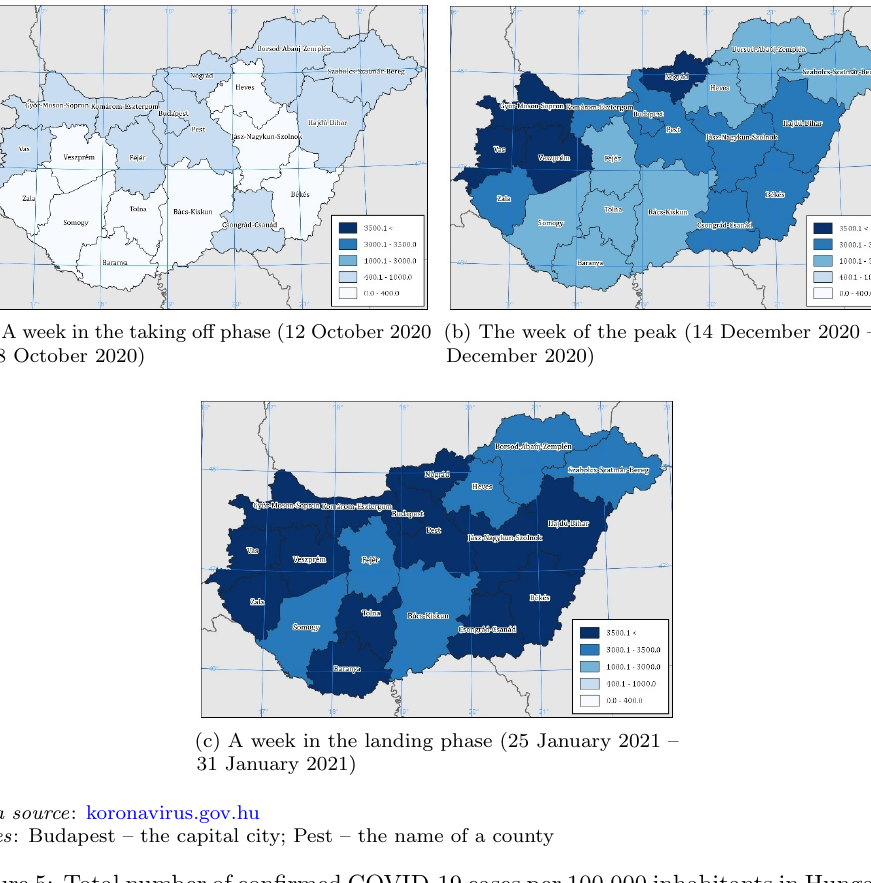
Figure 5: Total number of confirmed COVID-19 cases per 100,000 inhabitants in Hungarian counties (NUTS 3) during the different phases of the third wave, based on weeks survival rate is better than the rate in less developed areas in Hungary. Namely, a higher number and rate of deaths caused by COVID-19 was experienced in the socioeconomically disadvantaged parts of the country, e.g., inner peripheries, southern border, north-eastern regions etc. Poor health, lower life expectancy and a higher rate of cardiovascular diseases are also prevalent in these areas (Uzzoli et al.